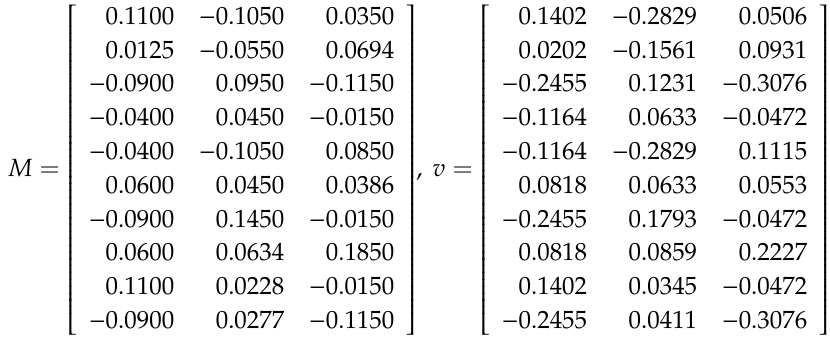
Table 2. Evaluation results given by experts.